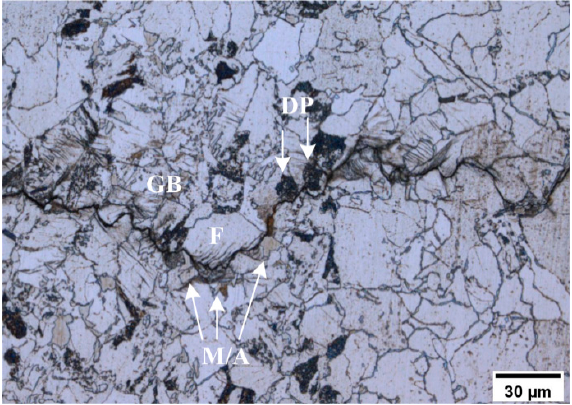
Figure 5. The partially enlarged view of the crack path of the LD1 specimen.